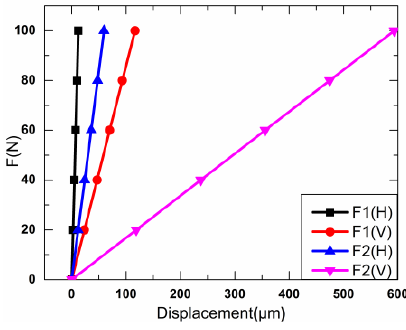
Figure 12. Relationship between the force and displacement. Table 6. Stiffness in the horizontal and vertical directions.